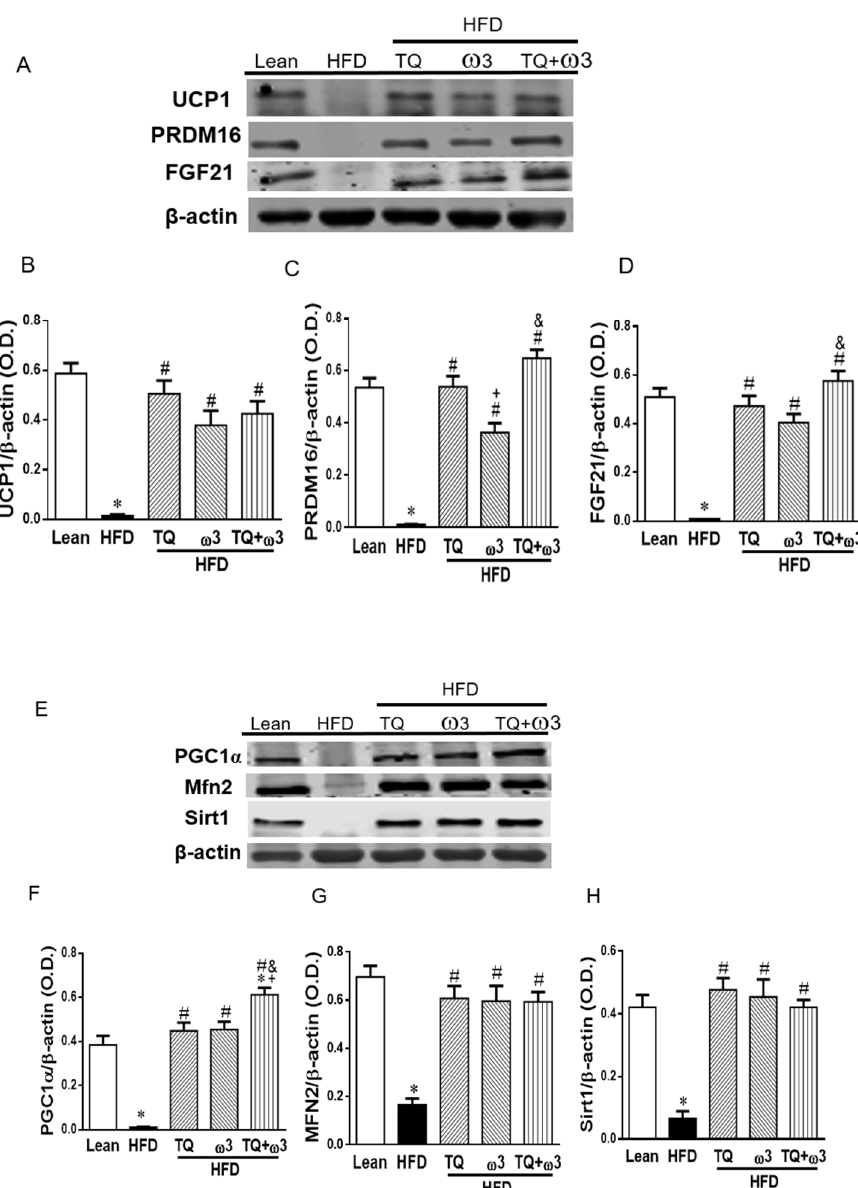
Figure 5. Effects of thymoquinone (TQ) and omega-3 ( ω 3) treatment on the key regulators of beige adipocyte and mitochondrial biogenesis in visceral adipose tissue of mice fed a high-fat diet (HFD). Representative Western blots ( A ) and densitometry analysis of uncoupling protein 1 (UCP1) ( B ), PR domain containing 16 (PRDM16) ( C ), and fibroblast growth factor 21 (FGF21) ( D ); Representative Western blots ( E ) and densitometry analysis of Peroxisome proliferator-activated receptor gamma coactivator 1-alpha (PGC1 α ) ( F ), Mitofusion 2 (Mfn2) ( G ), and Sirtuin 1 (Sirt1) ( H ). n = five animals per group. * p < 0.05 vs Lean; # p < 0.05 vs HFD, + p < 0.05 vs TQ, and & p < 0.05 vs ω 3.